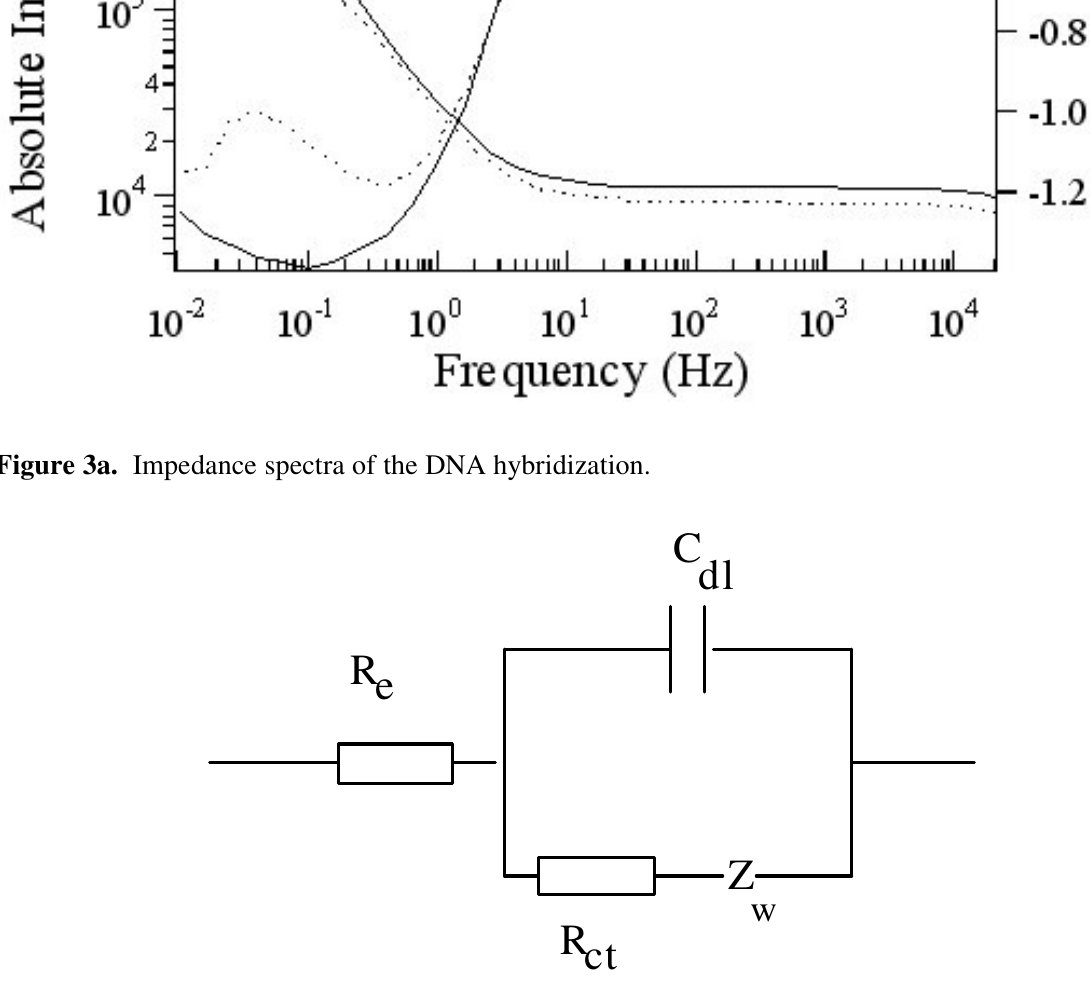
Figure 3b . Electric model used for the DNA hybridization the experimental frequency exponent, and 1.3x10 5 (cid:1)(cid:5) cm 2 for the Warburg impedance with the fitting